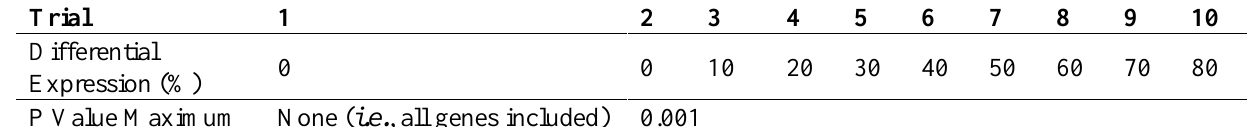
Table 5. Cut-Off conditions for gene inclusion to ―differential activity‖